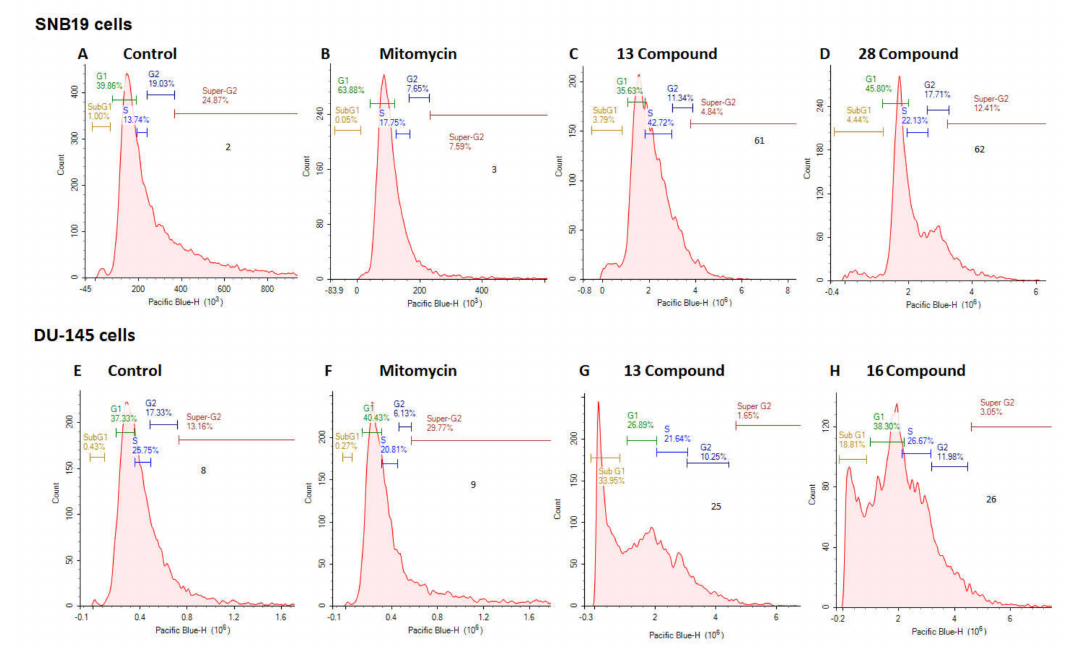
Figure 4. Induction of apoptosis by Mitomycin C ( B ), compounds 13 ( C ) and 28 ( D ) in SNB19 cells and Mitomycin C ( F ), 4-aryl-1-hydroxy-9,10-anthraquinones 13 ( G ), 16 ( H ) in DU-145 cells. Control (non-treated cells) ( A , E ). Data were obtained by flow cytometry (excitation 405 nm, emission 445 nm), in each sample 10,000 events were